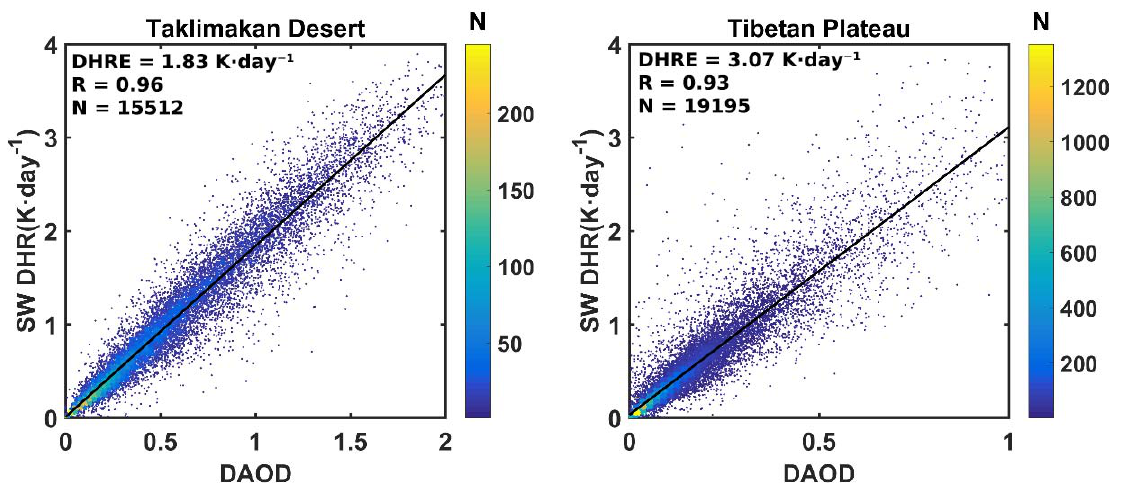
Figure 16. Scatterplots of monthly DAOD and column–averaged SW DHR. The color bar represents the number of samples.